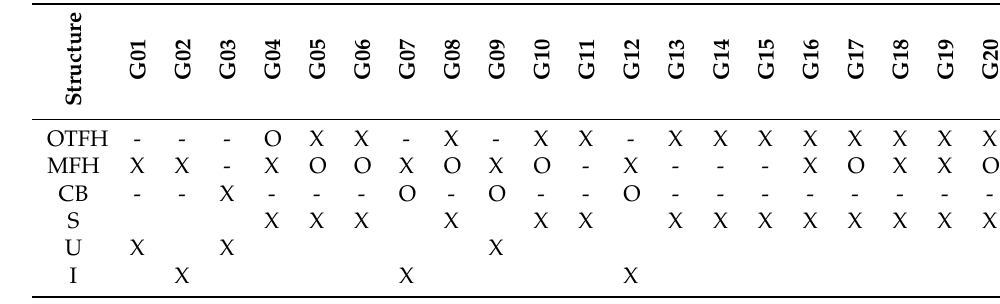
Table A3. Classification of building and urban structure based on location and building types for 20 low-voltage grids (with: OTFH = One- and two-family detached house, MFH = multi-family house, CB = commercial buildings, S = Suburban, U = Urban, I = Inner-city, X = high proportion, O = low proportion, - = negligible or not present) based on